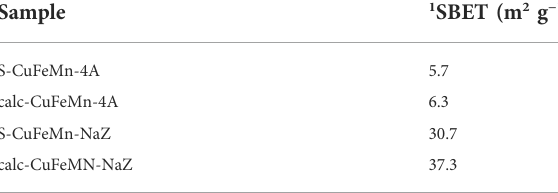
TABLE 3 Speci fi c surface area values of the investigated samples.